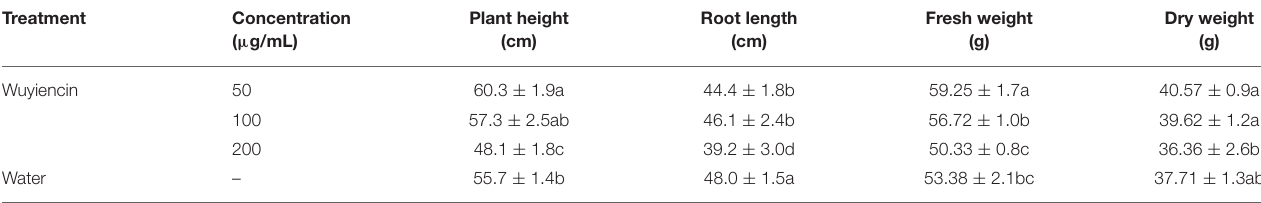
TABLE 3 | Effects of wuyiencin by root irrigation on soybean plant growth. Treatment